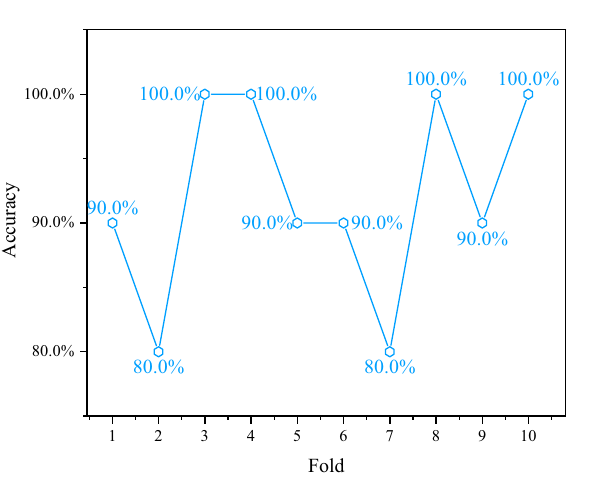
Figure 5. The validation chart of tenfold